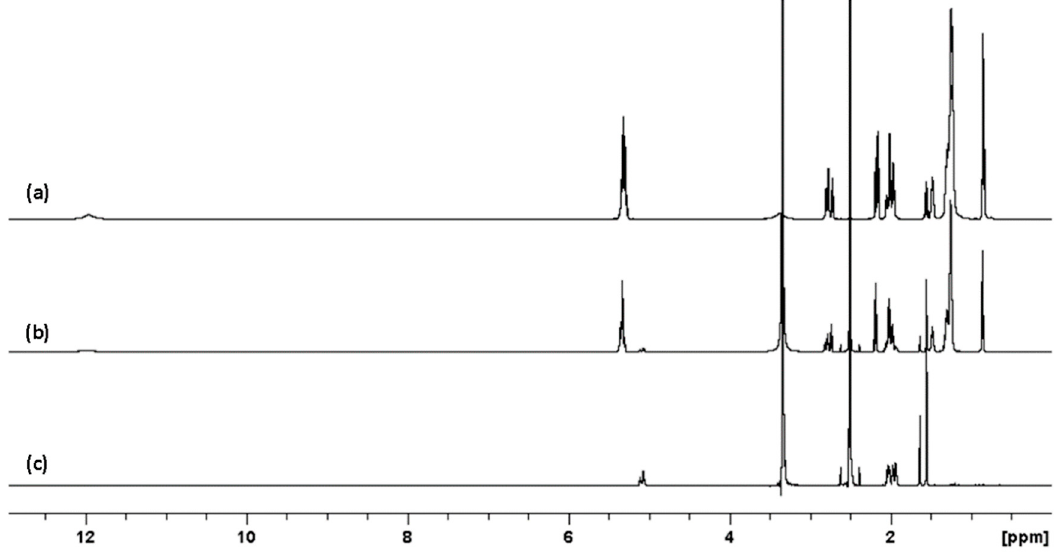
Figure 5. Proton NMR overlap for FFAs mixture ( a ), FFAs and squalene mixture ( b ) and squalene alone ( c ) in DMSO-d6. From Figure 5 above, it is evident that the unsaturation of the squalene and fatty acids resonates at slightly different chemical shifts, enabling potential identification of which substrates may be polymerising. Some of the proton signals of the FFAs (2.7–2.6 ppm) can also indicate crosslinking formation as the vinyl protons should shift as a result of radical addition to double bonds.